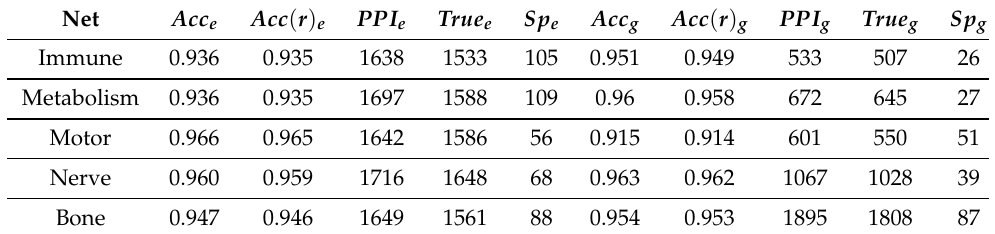
Table 7. The real (Acc) and random accuracy (Acc(r)) of relevant protein sequences extracted by the fractal method and those generated by bidirectional LSTM. e means extracted by fractal method, g means generated by bidirectional LSTM, and Sp means